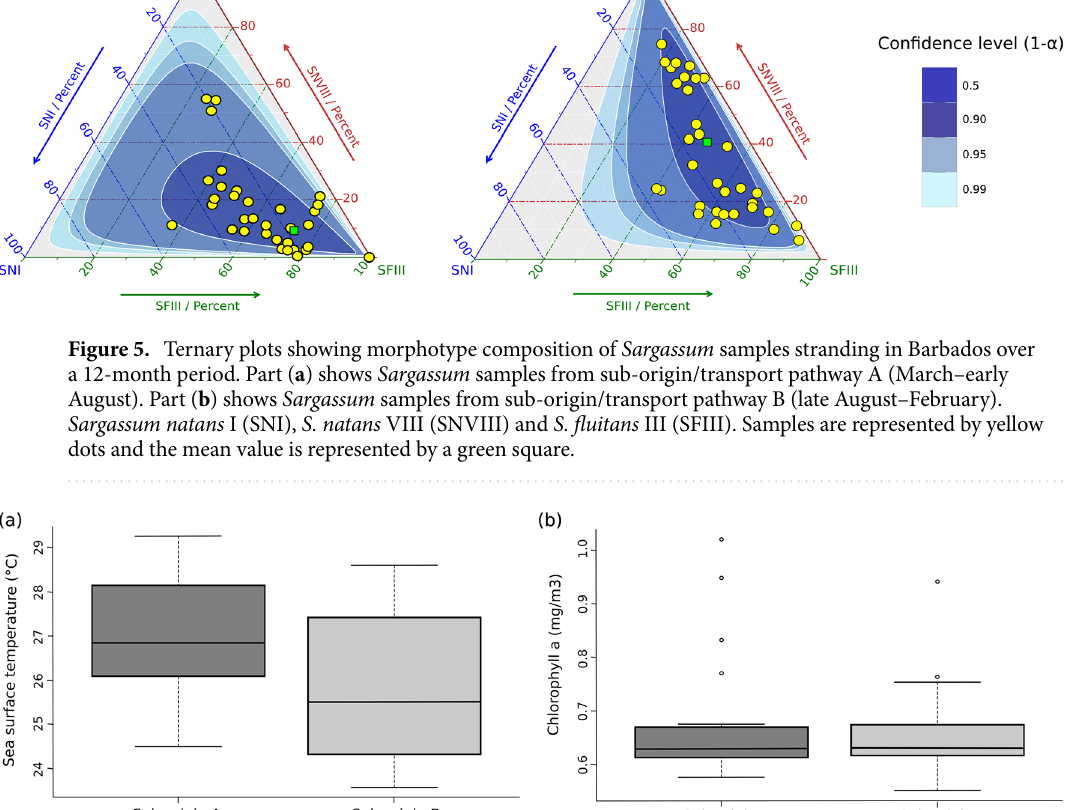
Figure 6. Boxplots of sea surface temperature ( a ) and chlorophyll a concentration ( b ) for sub-origin/transport pathway A and B (n = 48 in all